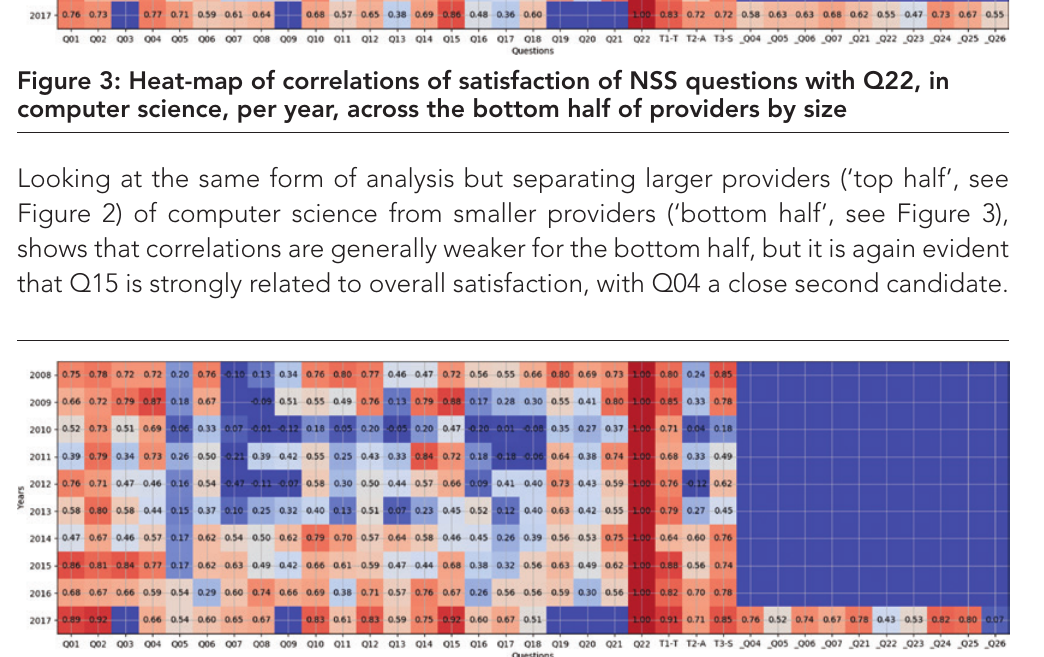
Figure 4: Heat-map of correlations of satisfaction of NSS questions with Q22,